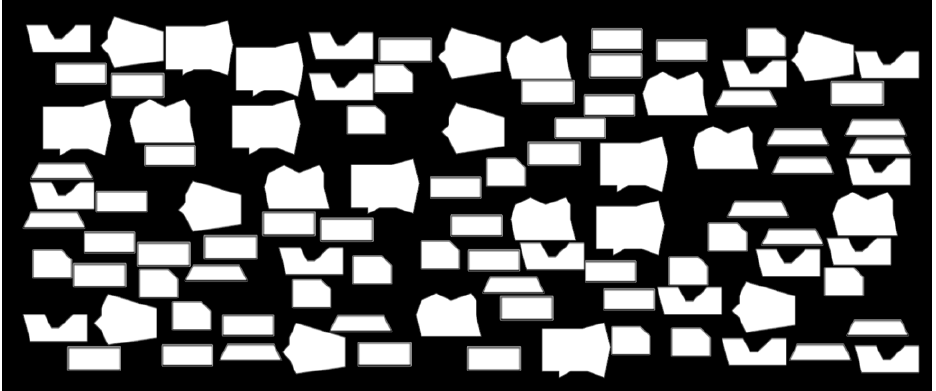
Figure 10. Solution found by the ILS algorithm using 99 pieces for the Shirts instance.